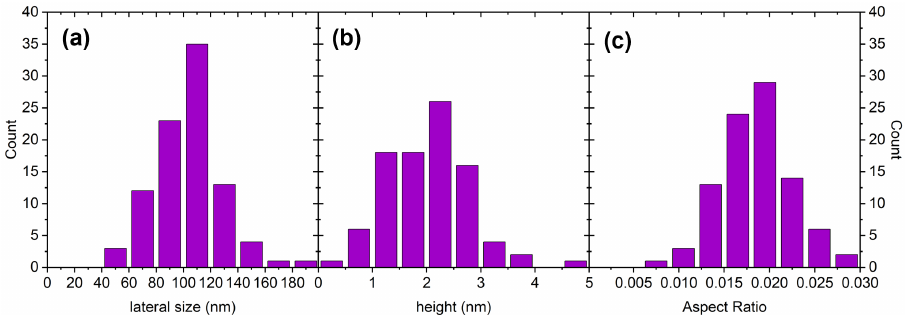
Figure A2. ( a ) Lateral size, ( b ) height and ( c ) aspect ratio distributions relative to Sample S6 (no capping).